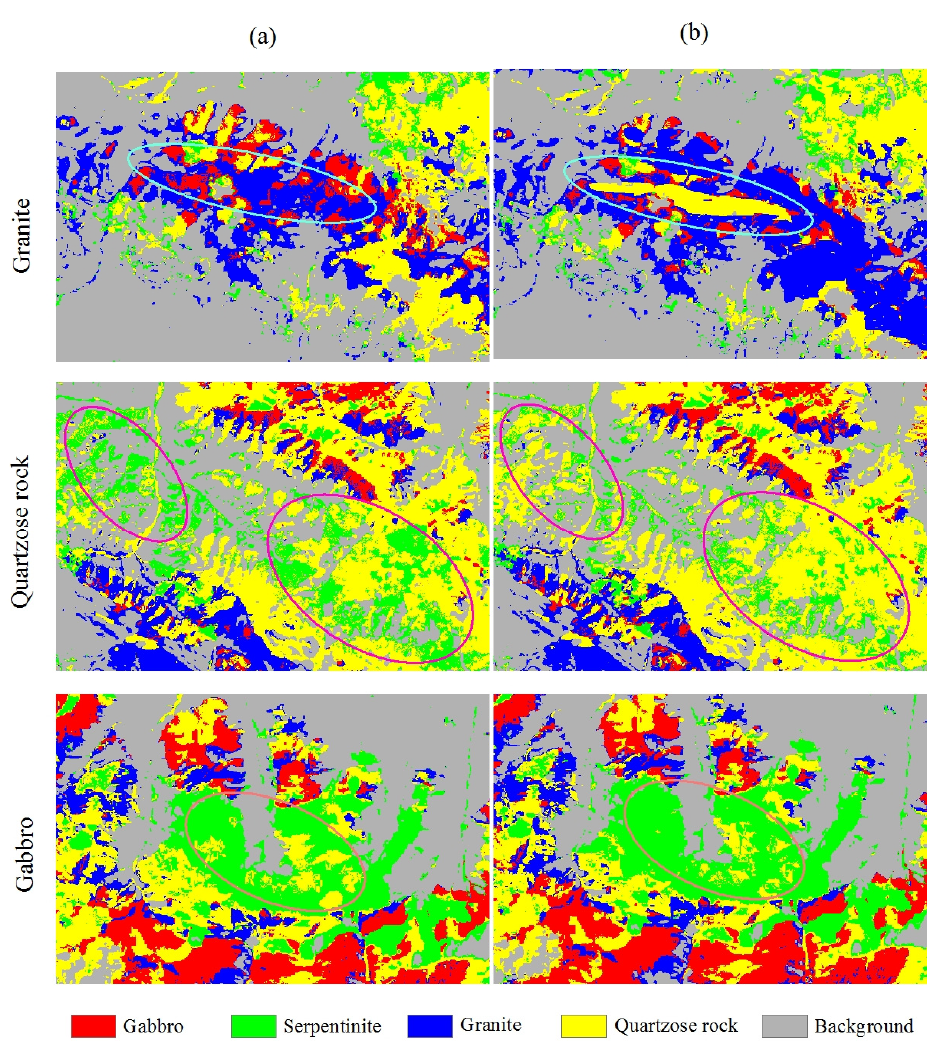
Figure 8. Zoom-in and comparison of classification results of ( a ) SVM with seven spectral vectors and Figure 8. Zoom ‐ in and comparison of classification results of ( a ) SVM with seven spectral vectors and no textural feature; and ( b ) SVM with seven spectral vectors fused with seven textural vectors for no textural feature; and ( b ) SVM with seven spectral vectors fused with seven textural vectors for gabbro, quartzose rock, and granite. The ellipses are used to highlight the changes between Figure 8 ( a ) gabbro, quartzose rock, and granite. The ellipses are used to highlight the changes between Figure 8 and ( b ( a ) and Figure ( b ). Figure 8. Zoom ‐ in and comparison of classification results of ( a ) SVM with seven spectral vectors and Table 4. Confusion matrix and accuracy evaluation of classification results using support vector no textural feature; and ( b ) SVM with seven spectral vectors fused with seven textural vectors for machine (SVM) with seven spectral vectors. gabbro, quartzose rock, and granite. The ellipses are used to highlight the changes between Figure 8 ( a ) and Figure ( b ). Table 4. Confusion matrix and accuracy evaluation of classification results using support vector machine (SVM) with seven spectral vectors.